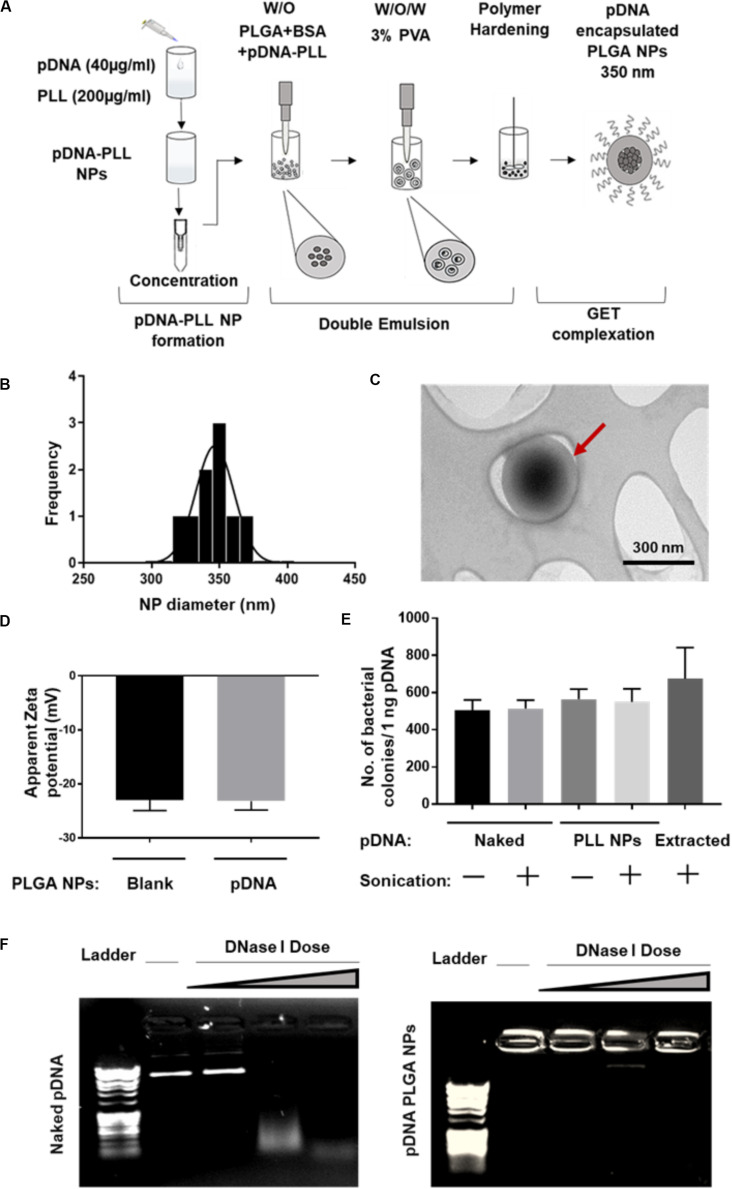
Characterization of pDNA-encapsulated PLGA NPs. (A) A simplified illustration of the process of pDNA encapsulated PLGA NP preparation and GET peptide complexation. (B) Representative PLGA NP size for both blank and pDNA encapsulated, shows homogenous population of the NPs measured by Zetasizer. (C) TEM micrograph of these NPs which confirms the size measured by Zetasizer and demonstrates the spherical, smooth surface of the NPs. Red arrow highlights individual NP. (D) The negative surface charge of pDNA-encapsulated PLGA NPs is comparable to blank NPs and excludes the possibility of PLGA NPs surface contamination with positively charged pDNA-PLL NPs. (E,F) Demonstrates the integrity of the encapsulated pDNA during the preparation process or the enzymatic treatment with DNase I respectively. Doses of DNase I tested were: 0.025, 0.0025, and 0.00025 U/μl with 15 min incubation time at 37°C.